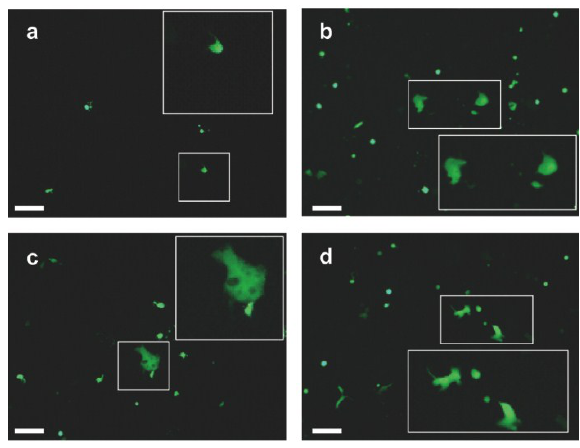
Figure 4. Transfection of African green monkey kidney (Vero) cells with EHV-4ΔgB. EHV-4ΔgB DNA was transfected in Vero cells ( a ) and Vero/gB4 cells ( b ). Also, parental EHV-4 DNA was transfected in both Vero ( c ) and Vero/gB4 cells ( d ). After 48 h of incubation, cells were inspected with an epifluorescent microscope (Zeiss Axiovert, Jena, Germany) and images were taken with a CCD camera (Zeiss Axiocam, Jena, Germany). The bar represents 100 μm and the white frames contain magnified inserts of the selected areas. Plaque formation of the gB-negative EHV-4 mutant was only evident on Vero/gB4 but not parental Vero